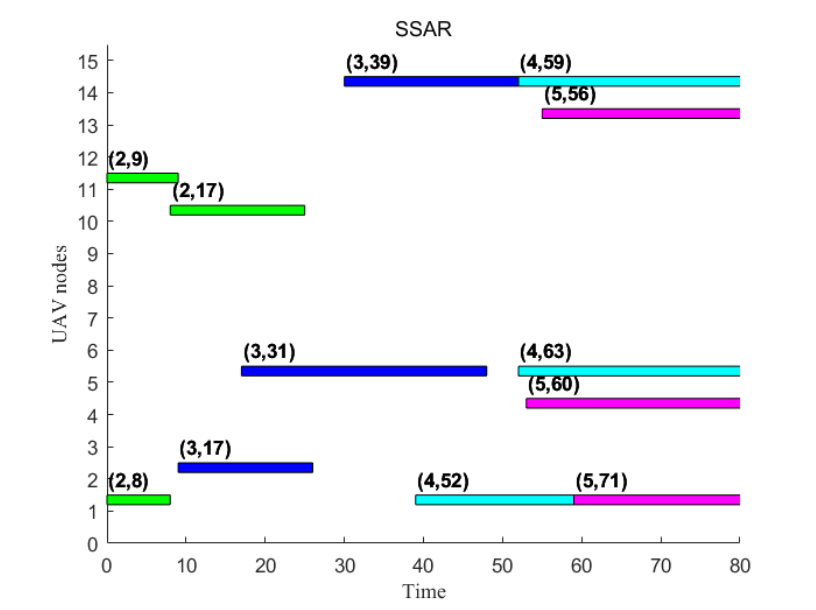
Figure 13. The Gantt comparison of task